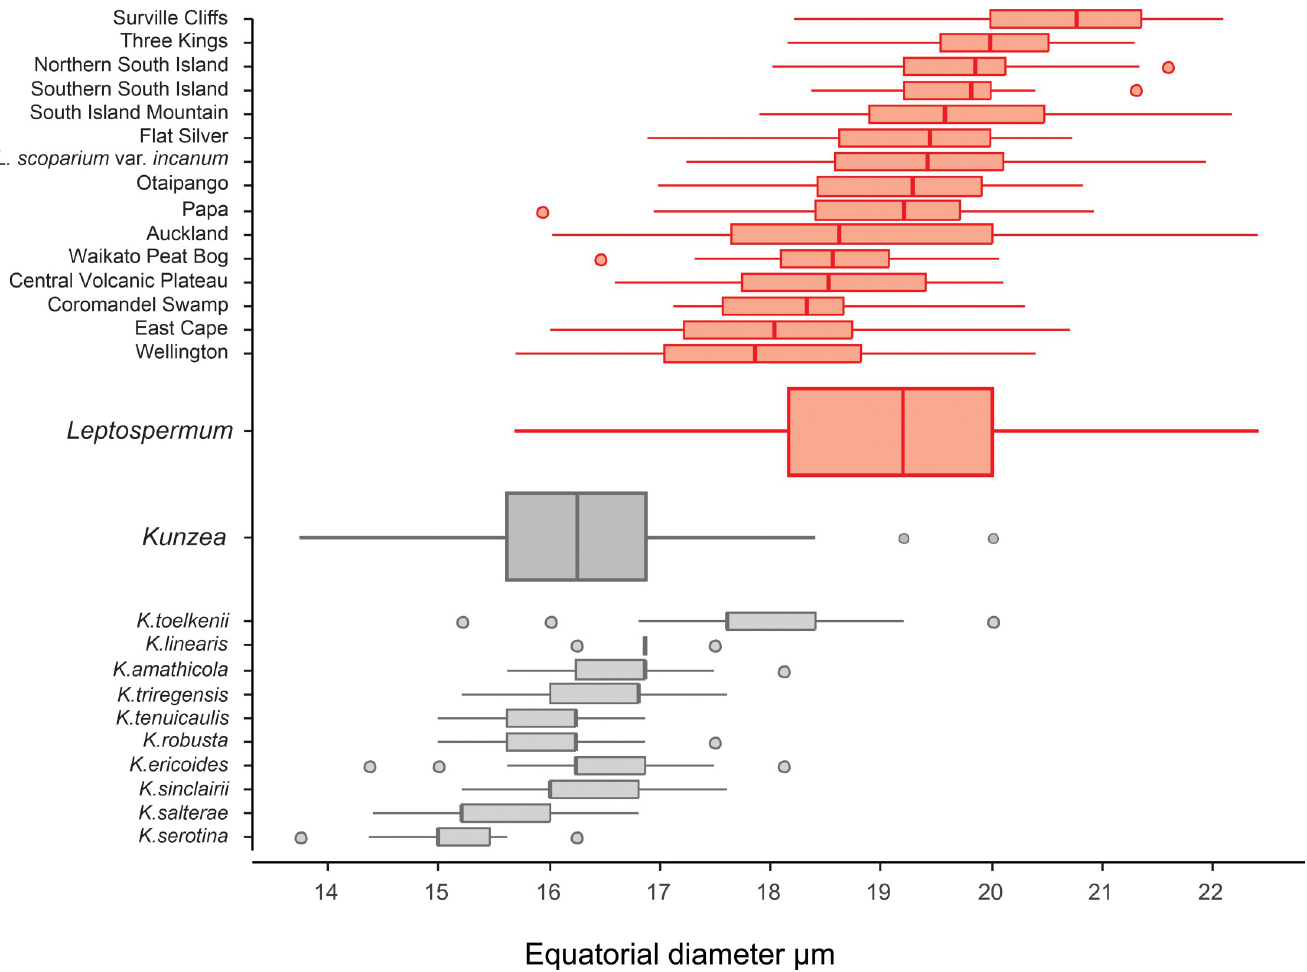
Fig 12. Size range of Leptospermum scoparium and Kunzea in equatorial diameter under light microscope. Leptospermum scoparium –upper, red; Kunzea –lower, grey.